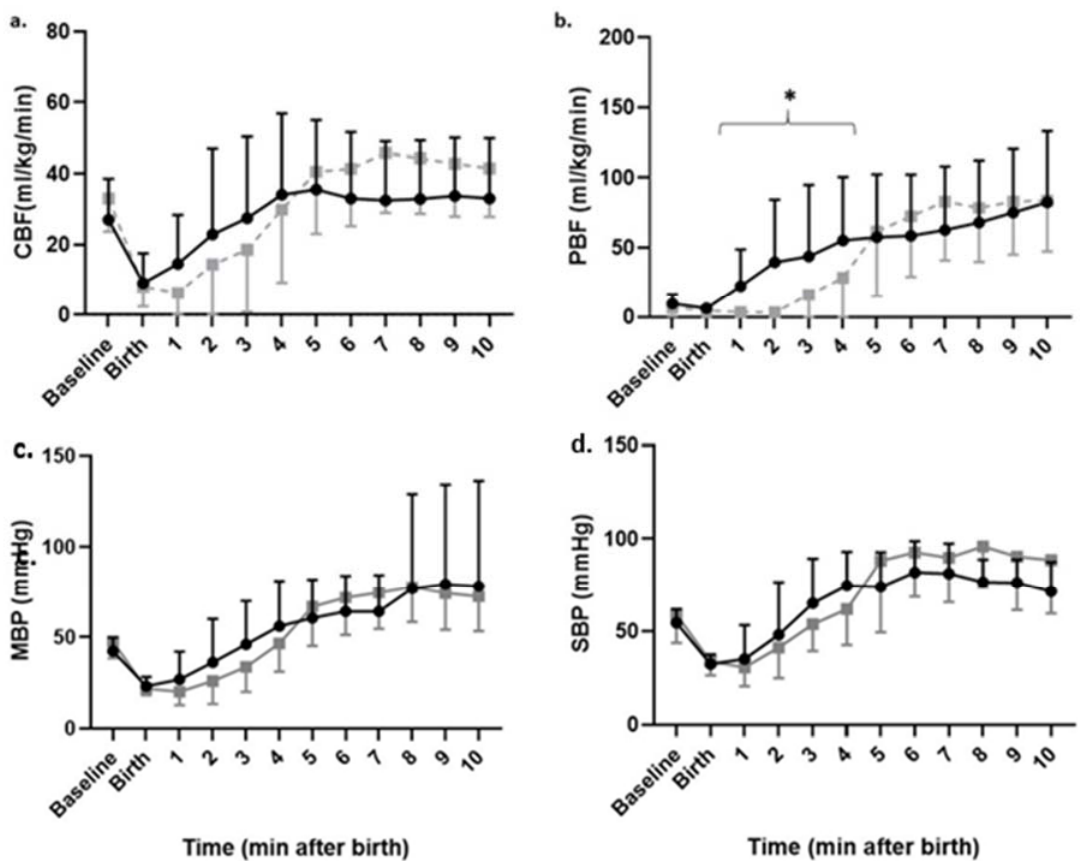
Figure 3. Post resuscitation hemodynamics in the first 10 min after birth in ventilation groups—effect of sustained inflation (gray squares, N = 13) is compared to positive pressure ventilation (Black circles, N = 10): ( a ) carotid blood (CBF), ( b ) pulmonary blood flow (PBF), ( c ) mean blood pressure (MBP) and ( d ) systolic blood pressure (SBP). Data are represented as mean ± SD. * p < 0.01 by repeated measures ANOVA.